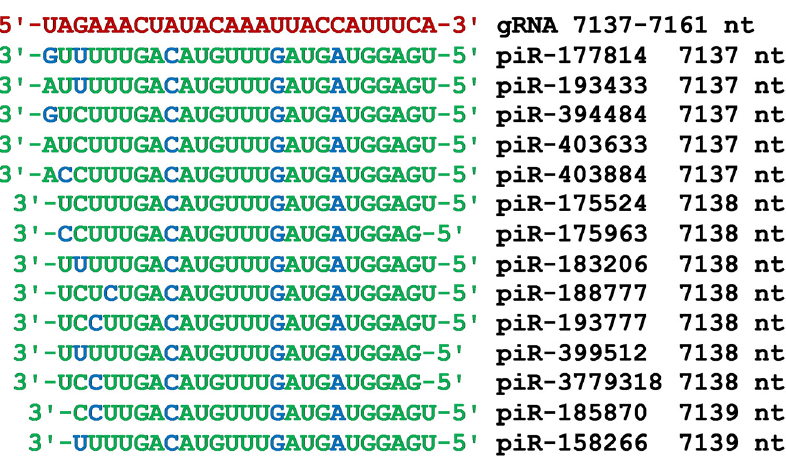
Figure 5. Nucleotide sequences of the piRNA BSs cluster in the CDS of gRNA from 7137 nt to 7161 nt and the nucleotide sequences of four piRNAs. Note: The piRNA nucleotides that form canonical pairs with gRNA are highlighted in green and non ‐ canonical pairs are highlighted in blue. The names of the piRNAs are followed by the beginning of their BSs.